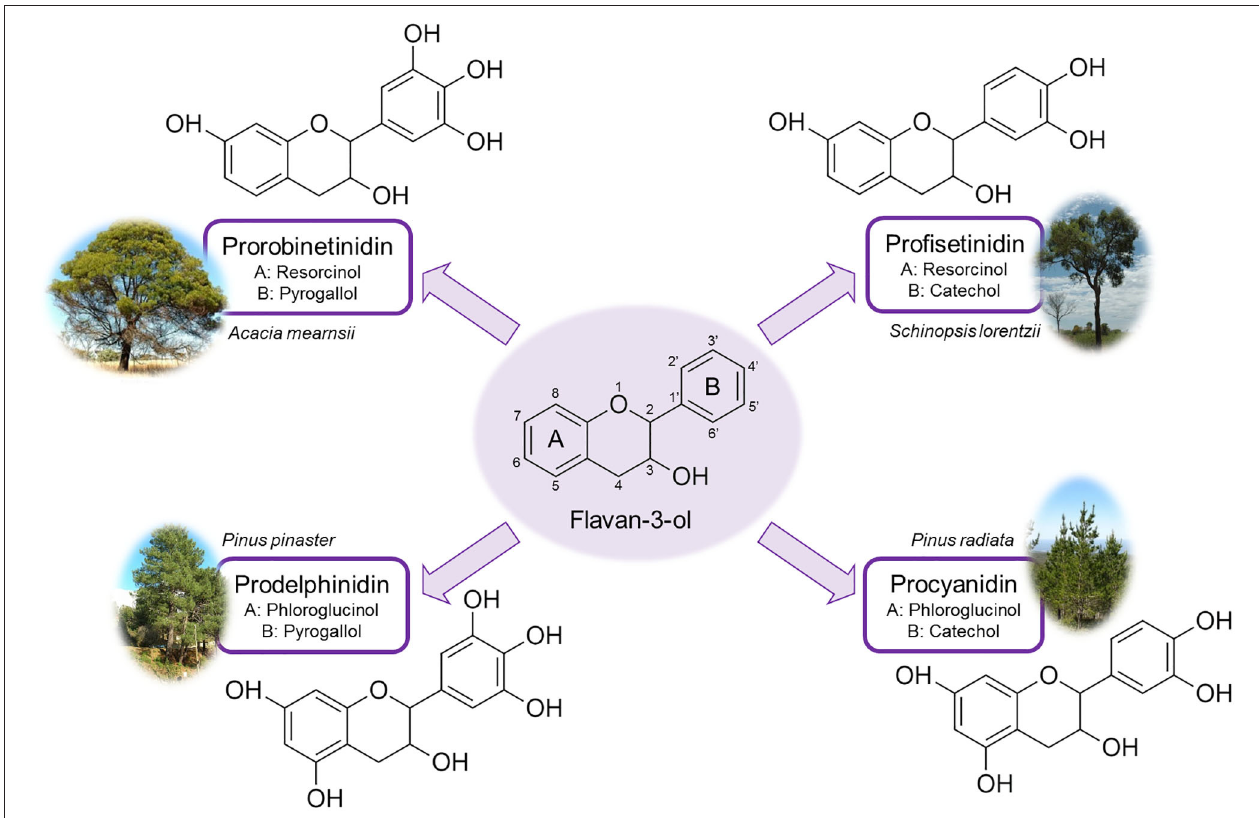
FIGURE 9 | Main flavonoid units of condensed tannins, along with the plant commonly used for their extraction (Fierro et al., 2018; Shirmohammadli et al.,